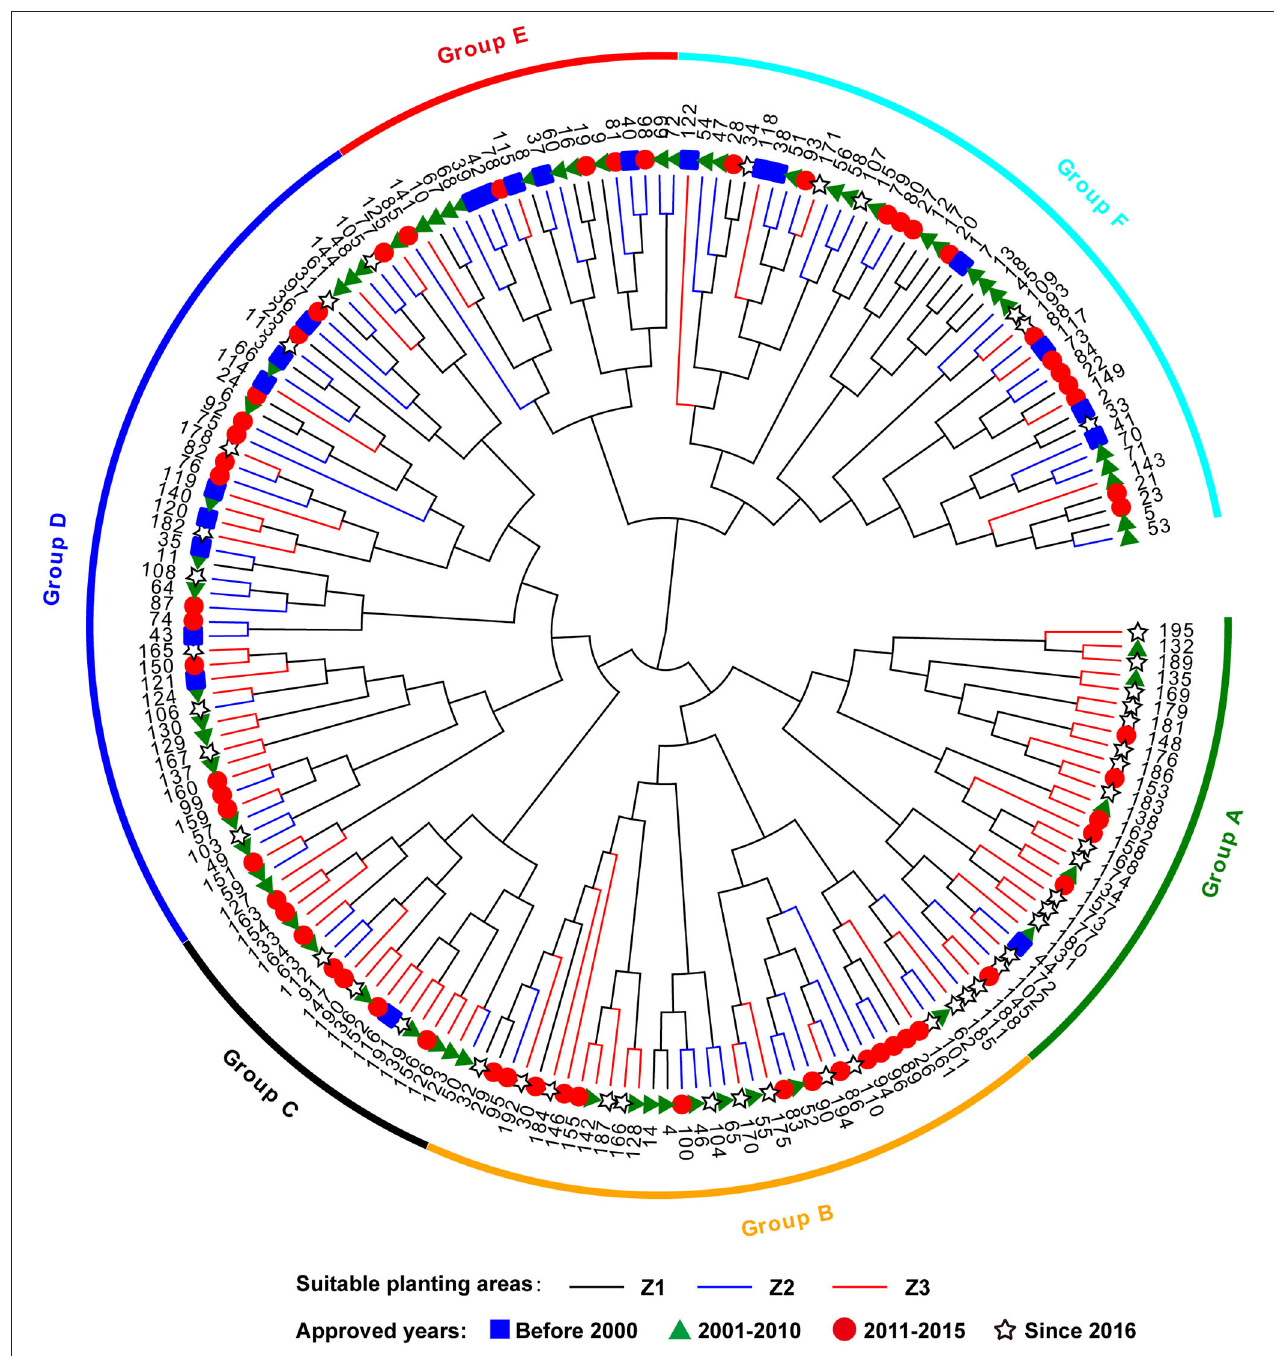
FIGURE 6 | Cluster dendrogram of 195 wheat varieties based on DUS testing characteristics. The variety information corresponding to the number is listed in Supplementary Table 1 . Squares, triangles, circles and stars represent wheat varieties from group I, II, III and IV according to the approved time. The black, blue and red lines represent wheat varieties from the Z1, Z2, and Z3 zones,